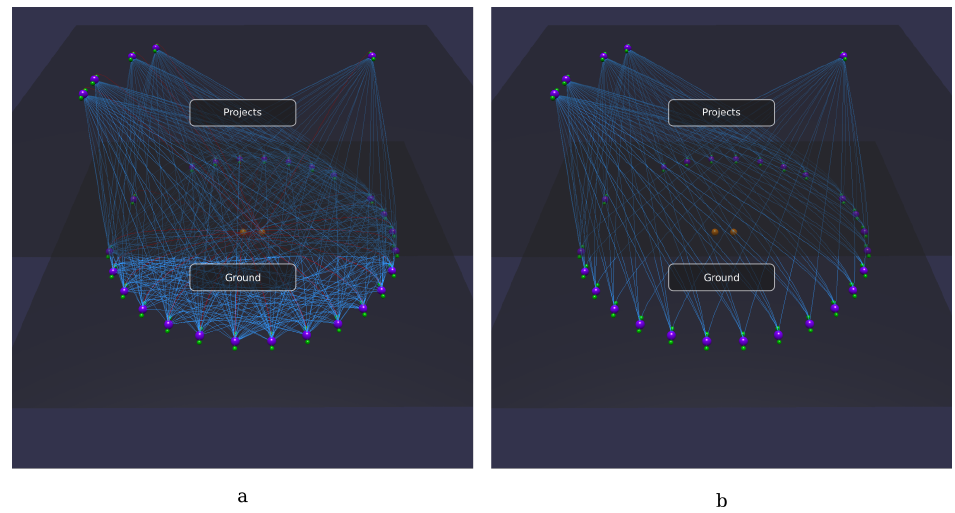
Figure 8. Use Case #1, Question 2: The semantic plane of the projects clearly highlight that all projects are bound to at least one person ( a ). This is more evident when unnecessary edges are hidden ( b ). Question 3 : Do Person1 and Person2 share any projects? The third question can, once again, be answered through a SPARQL query: